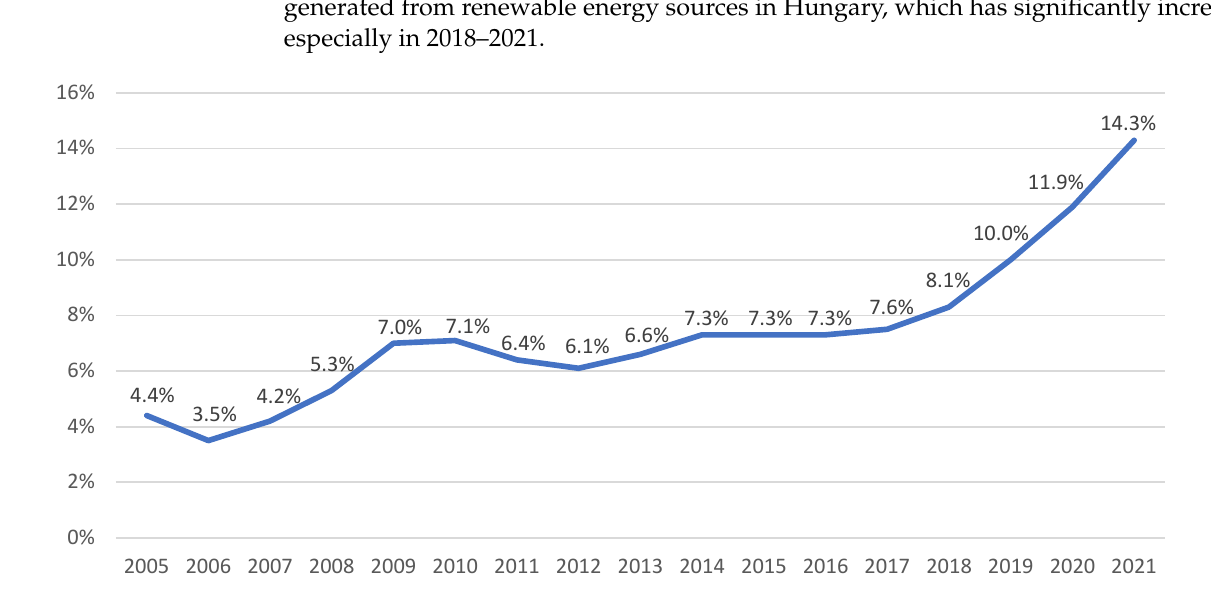
Figure 1. Share of electricity from renewable energy sources in gross final electricity consumption in Hungary, 2005–2021 (%) [26] .